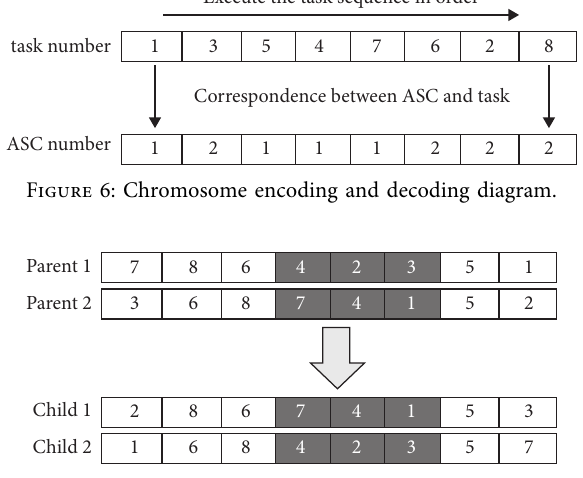
Figure 7: Chromosome swap